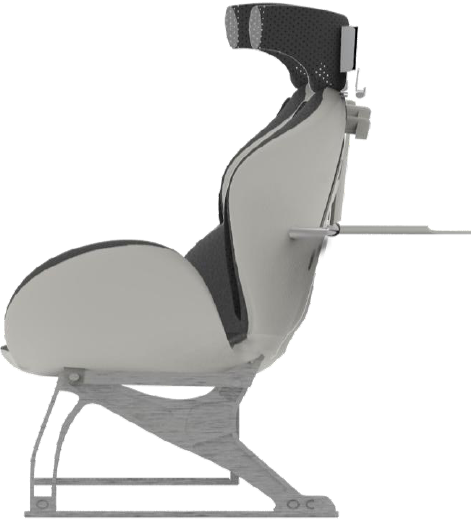
Figure 41. Side view of final product.